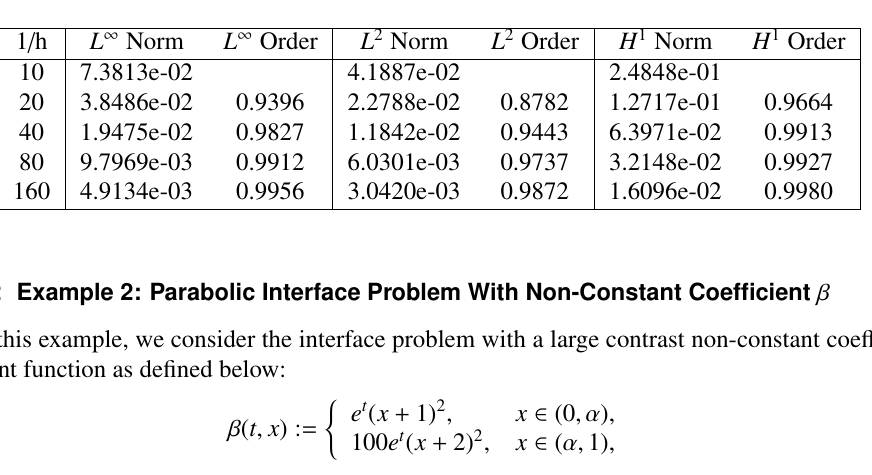
Table 2. Errors and Convergence Rate for Linear IFEM-BE Approximation for Example